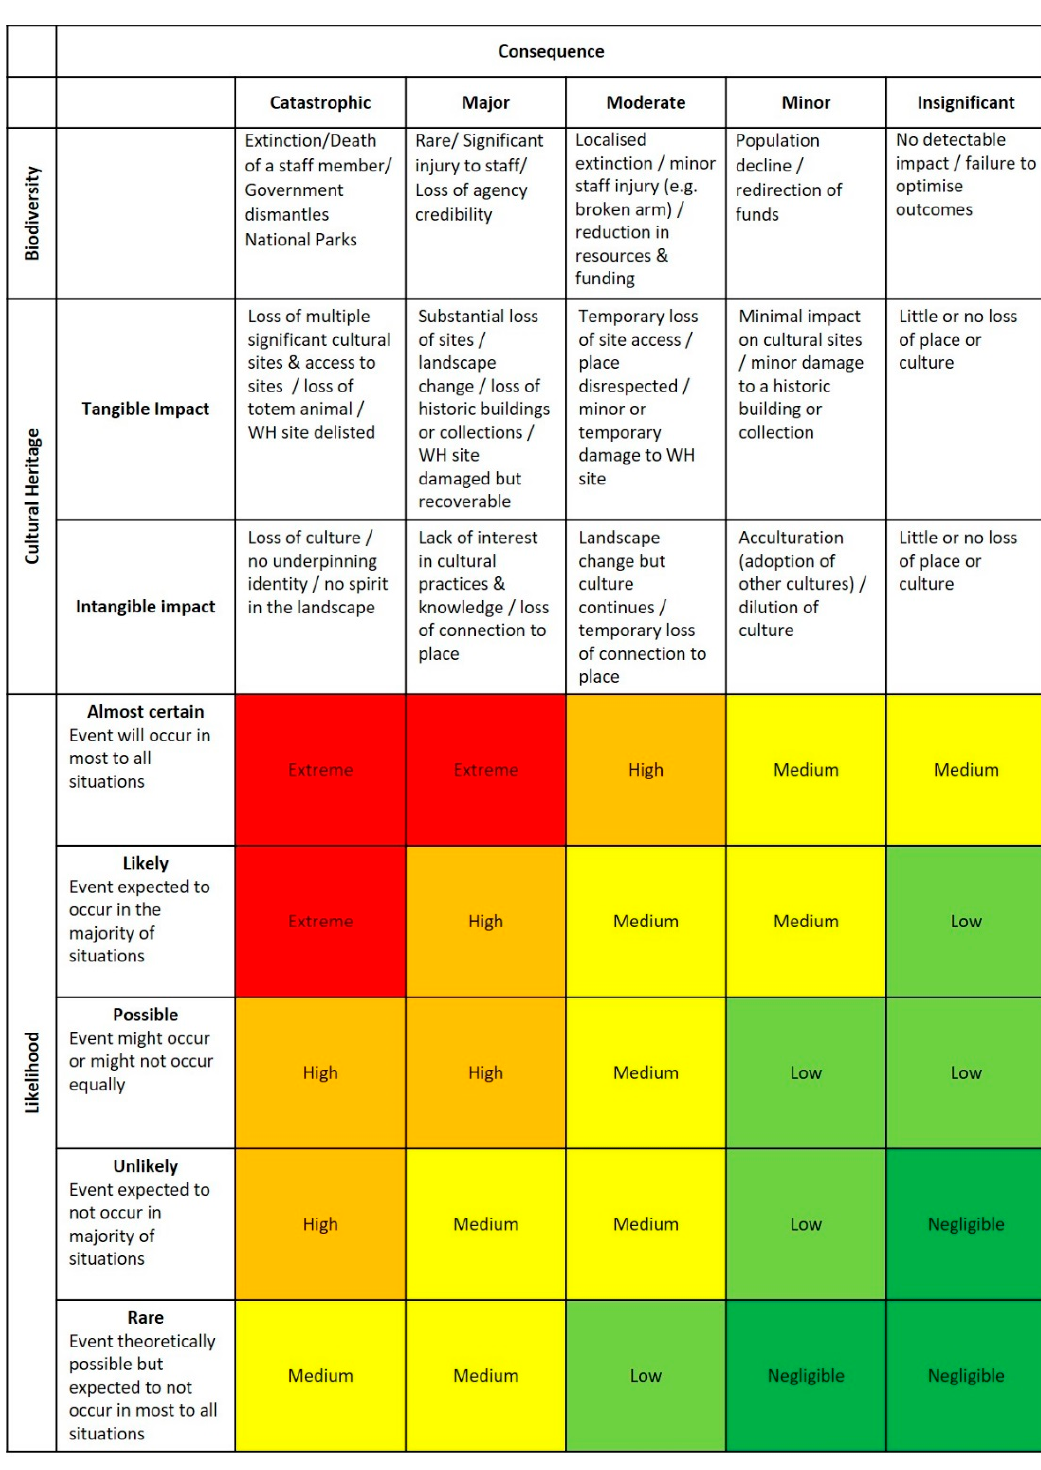
Figure 2. Risk management matrices used to develop adaptive management pathways for biodiversity and cultural heritage. Adapted from [29].